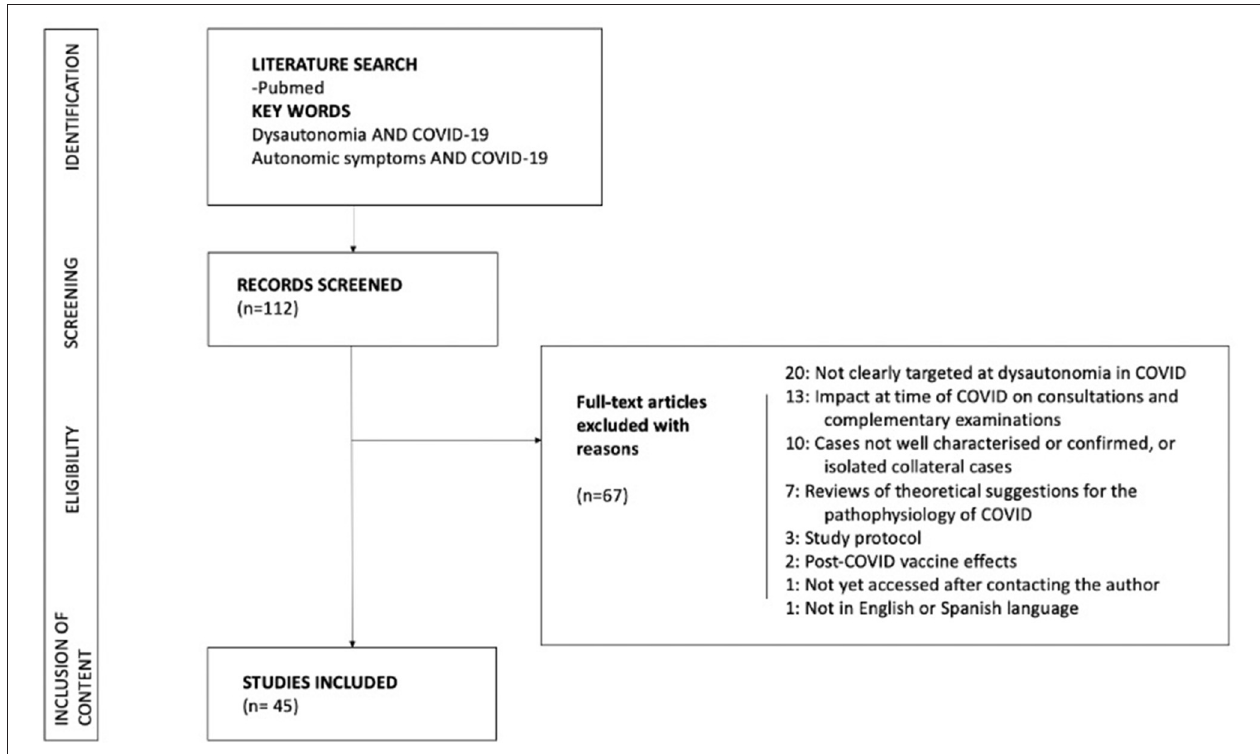
FIGURE 1 | Flow chart of the